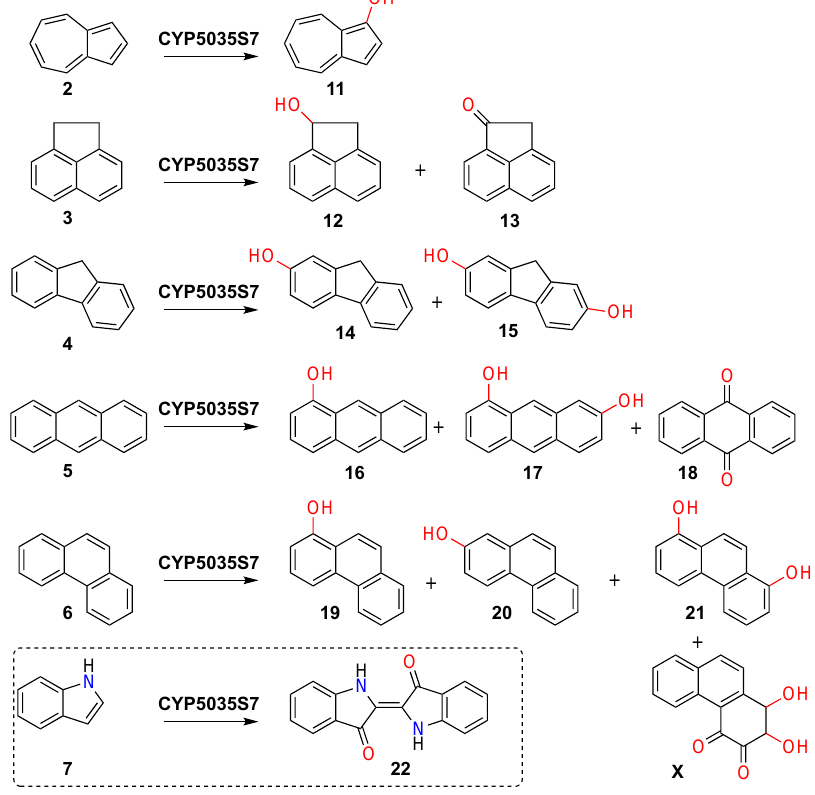
Scheme 1. Products identified from the CYP5035S7-catalysed biotransformations of 2 , 3 , 4 , 5 , and 6 employing a P. pastoris whole-cell